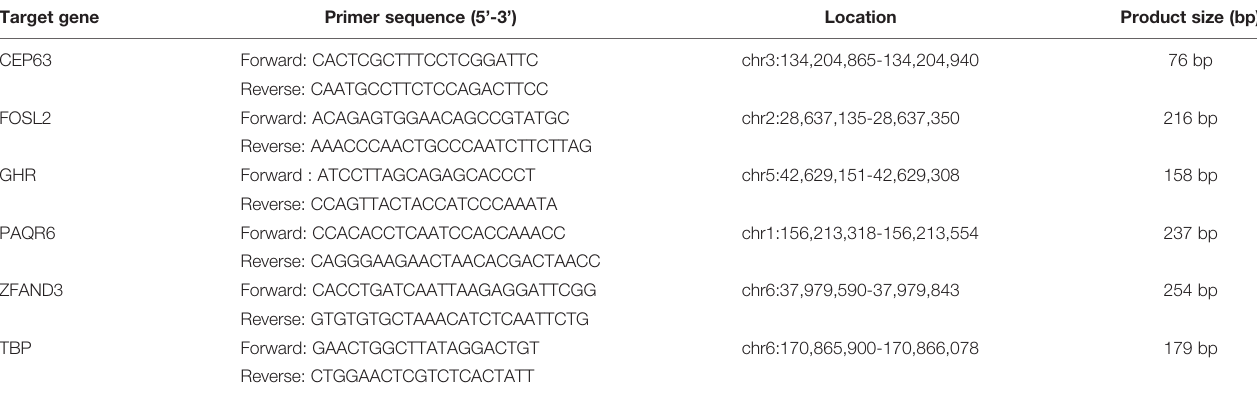
TABLE 2 | Sequence of primers for real-time fl uorescence quantitative PCR to detect the CNVs of candidate genes. Target gene Primer sequence (5 ’ -3 ’ )